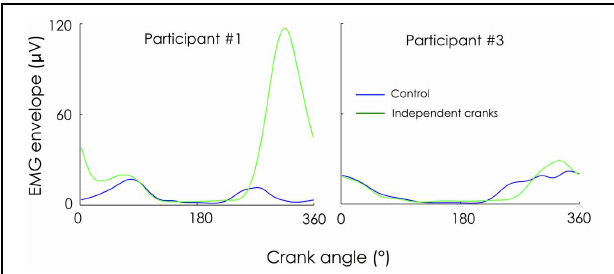
FIGURE 5 | Example of two different adaptations for the rectus femoris. EMG envelopes are not normalized (expressed in microvolts) and thus contain information on both muscle activity level and distribution of this activity within the cycle. While participant #1 increased RF activity level by about 500% during the “independent cranks” condition, RF recruitment was not altered in participant